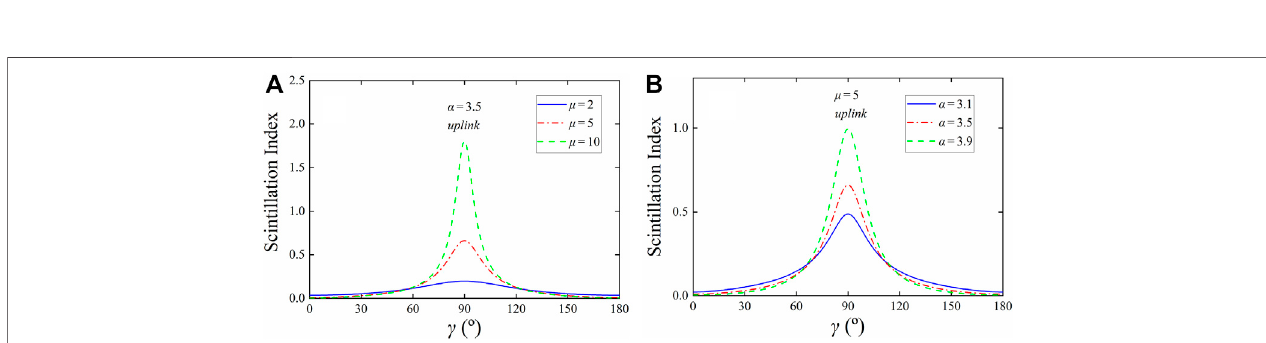
FIGURE 4 | Scintillation index of the uplink versus the anisotropic tilt angle γ . (A) With various anisotropic factor μ values; (B) with various power law α values.